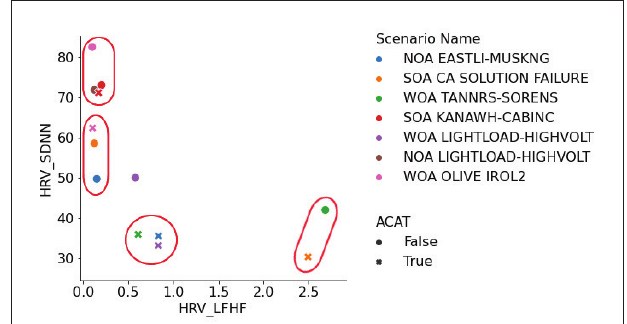
FIGURE 3 | HRV metrics computed for each trial. Descriptions of each metric are provided in Section 3.1. FIGURE 4 | HRV clusters identified in a scatter plot of SDNN vs.